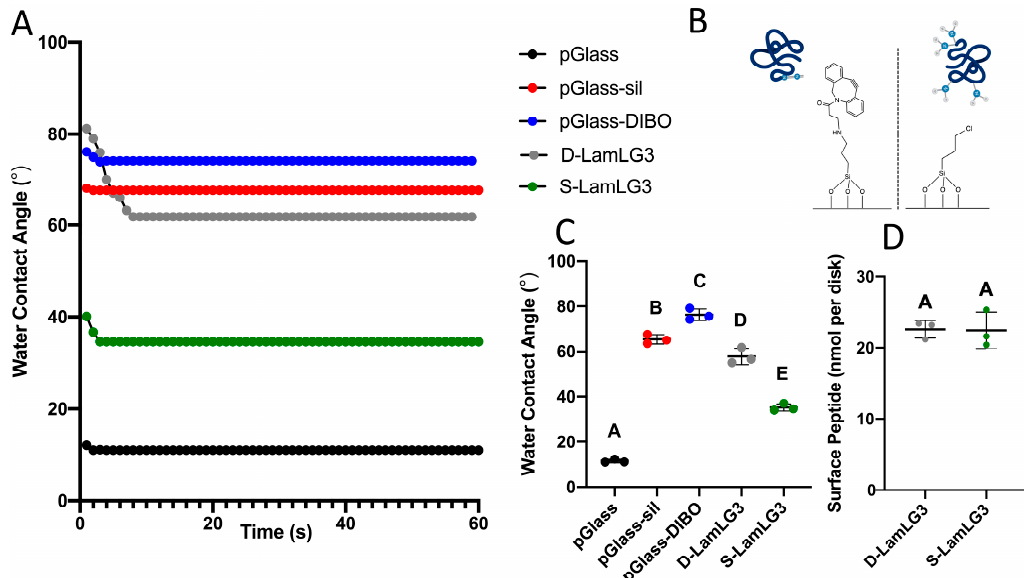
Figure 2. Dynamic water contact angles for LamLG3-coated and non-coated, control surfaces ( A ); schematic illustrating immobilization site(s) and chemistries of D-LamLG3 ( B , left) and S-LamLG3 ( B , right); water contact angles at equilibrium ( C ); and amount of peptide on D-LamLG3 and S-LamLG3